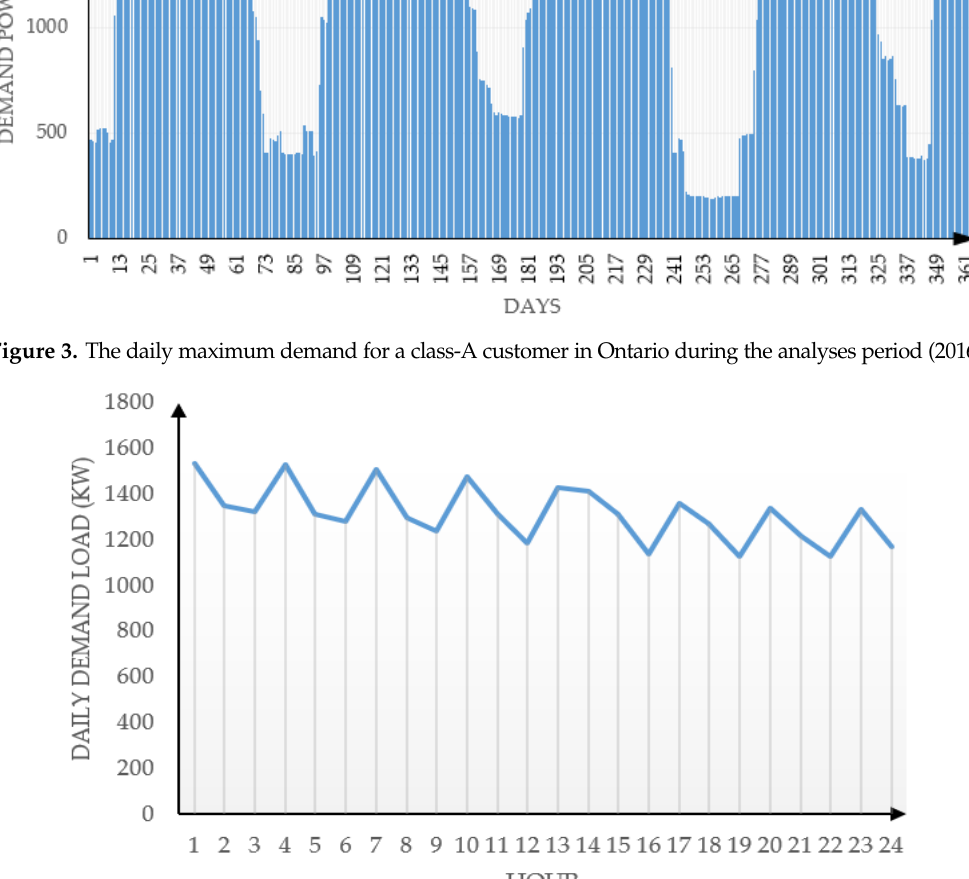
Figure 4. Typical hourly maximum demand for a class-A customer in Ontario (2016).